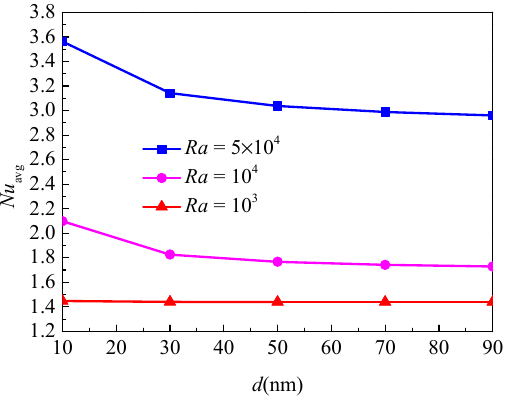
Figure 10. Average Nusselt number ( Nu avg ) of the inner wall for different nanoparticle diameters ( d sp ) and Rayleigh numbers ( Ra ) at Da = 10 − 2 , φ = 0.05, ε = 0.5, and RR = 2.